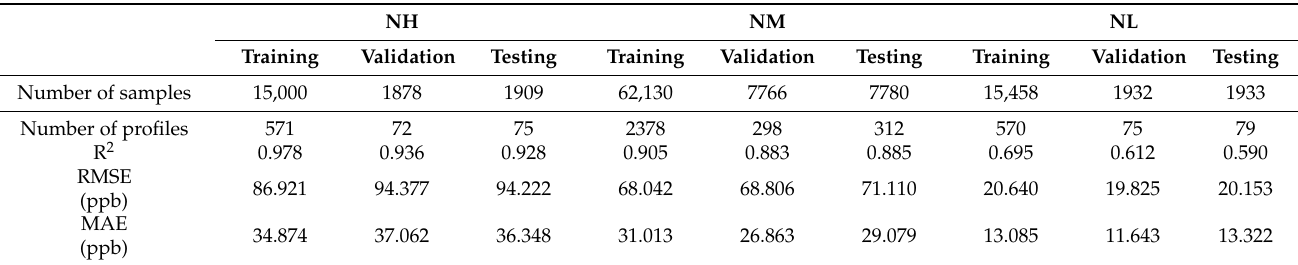
Table 2. Training, validation, and testing results in the Northern Hemisphere. RMSE: root mean square error; MAE: mean average error.